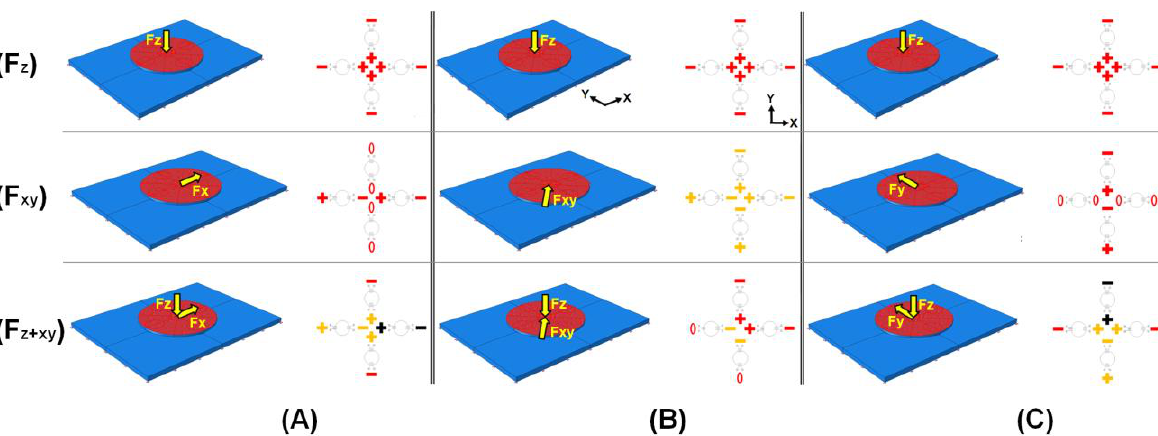
Figure 6. ( A ) Strain distribution under applied normal load, + x -direction (0°) tangential load, and superposition of normal and tangential load; ( B ) Strain distribution under applied normal load and diagonal-direction (45°) tangential load and superposition of normal and tangential load; ( C ) Strain distribution under applied normal load and + y -direction (90°) tangential load and superposition of normal and tangential